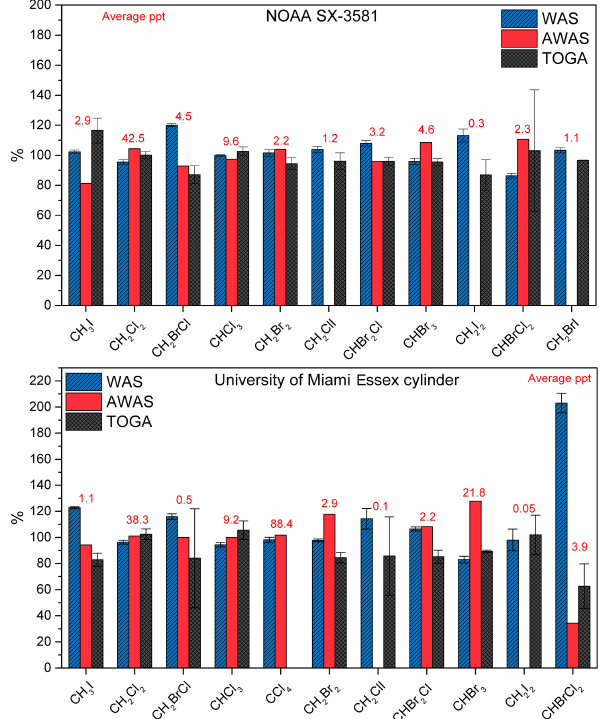
Figure 2. Inter-calibration results from the two calibration gases, shown normalised to the average for each species. Values in red de- note concentrations of analytes in the respective standards; whiskers show ± %RSD.